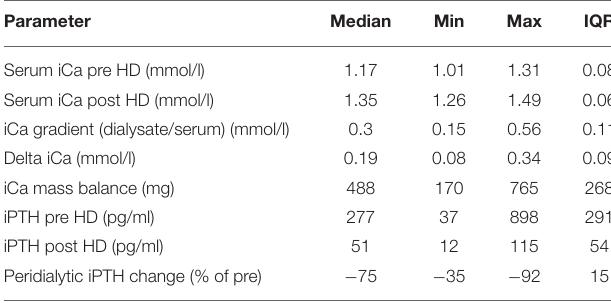
TABLE 2 | Intradialytic iCa kinetics, iCa mass balance, and peridialytic iPTH change ( n =